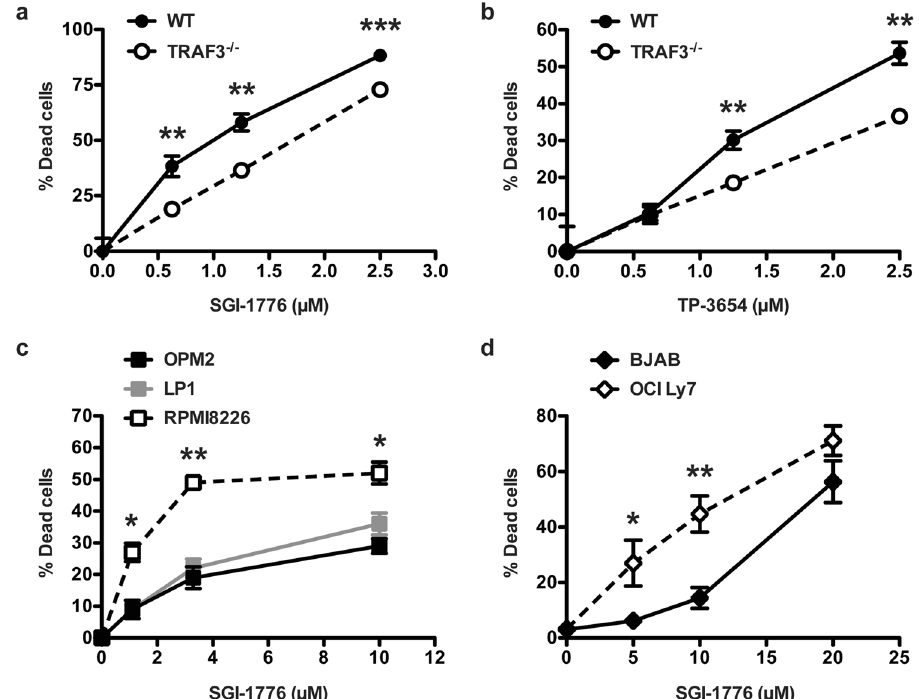
Figure 5. Effect of TRAF3 on susceptibility to kinase inhibition in mouse primary B cells and human MM and DLBCL cell lines. ( a , b ) Splenic B cells at 1 × 10 6 B cells per well were treated with indicated doses of Pim inhibitors for 24 hrs. The viability was determined by PI exclusion. The percent viability was calculated as the mean viability of inhibitor-treated samples normalized to DMSO vehicle-treated sample for each genotype. Graphs indicate mean values ± SEM of percent viable cells treated with SGI-1776 ( a ) or TP-3654 ( b ). Graphs are representative of 3 independent experiments (N = 4). An unpaired Student’s t test was used to evaluate differences for statistical significance ( * p < 0.05, ** p < 0.01). ( c , d ) MM ( c ) and DLBCL ( d ) cell lines (5 × 10 3 /well) were treated with indicated doses of SGI-1776 for 24 hrs. The viability was determined by